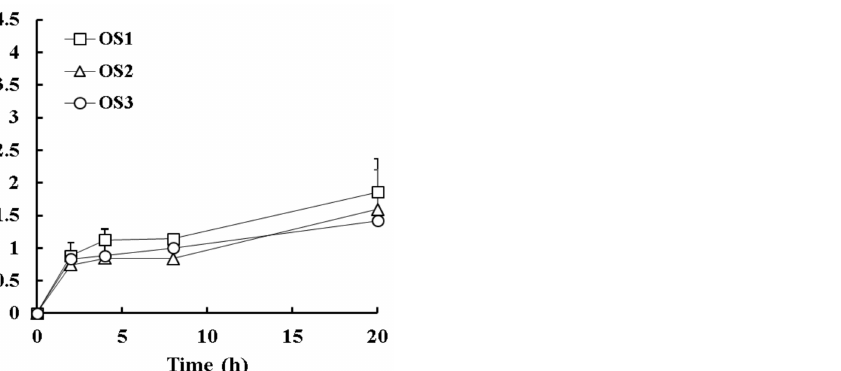
Figure 4. In vitro permeation profile of efinaconazole through the bovine hoof from oil solutions (OSs) prepared with different oily vehicles in the Franz diffusion cell model. Data represent mean ± standard deviation ( n = 3).